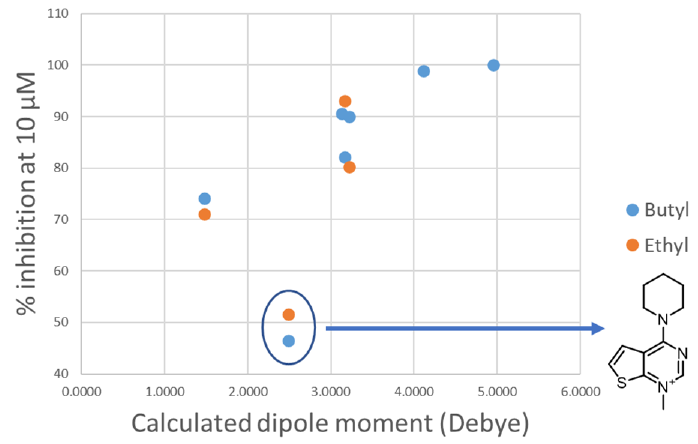
Figure 8. Plot of the experimental percentage inhibition at 10 μM against the calculated dipole moment of the heads for the classes of compounds containing a butyl or ethyl linker (blue dots and orange dots, respectively). The outlier head is circled in blue and the structure is reported on the right.